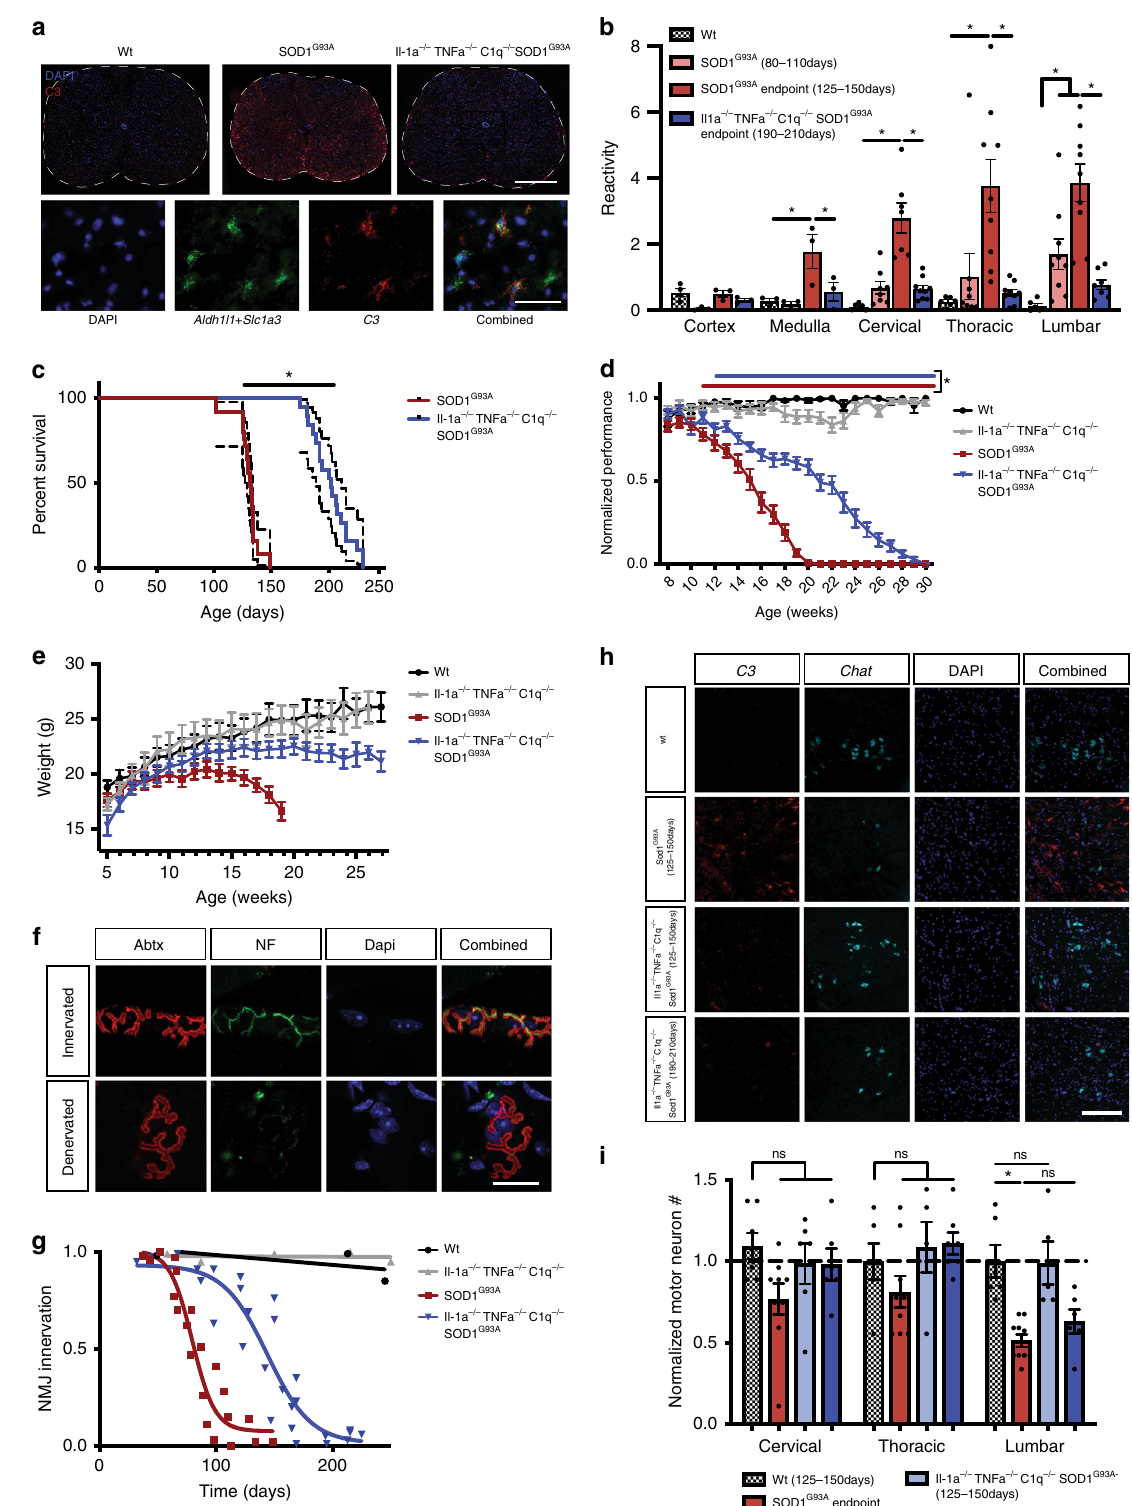
microglia from WT or SOD1 G93A mice by immunopanning 27 or MACS isolation 28,29 and cultured them in serum-free condi- tions 30 . Unexpectedly, WT and SOD1 G93A astrocytes and microglia were strikingly similar when quiescent (Fig. 2a, b, Supplementary Fig. 4; http://www.gliaseq.com). This stands in stark contrast to the overall transcriptomic excitability of